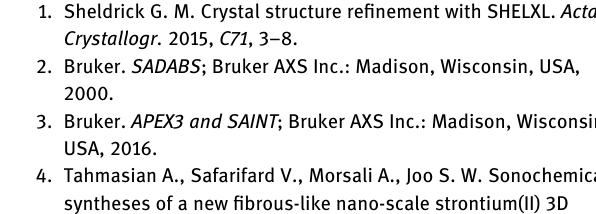
(1 H -imidazole-4,5-dicarboxylate anion (H Phbidc 2 − ), two 4 halfs of coordination water molecules and two uncoordi- nated water molecules. Each Ni1 ion is six-coordinated and located in a distorted octahedral NiN O coordination 2 4 environment formed by two N atoms (N1 and N1#1) and two O atoms (O1 and O1#1) from one H Phbidc 2 − anion and by 4 two water molecules (O5 and O6). The Ni – N bond lengths is 2.0133(18) Å and the Ni – O bond lengths are 2.046(3), 2.099(3), 2.1028(16) and 2.1029(16) Å, respectively; these values are within the normal ranges and close to those reported in other Ni(II) complexes [15 – 17]. The bond angles of O6 – Ni1 – O5, N1 – Ni1 – O1#1 and N1#1 – Ni1 – O1 are 171.94(12) ° , 173.30(7) ° and 173.30(7) ° , respectively. The other bond angles around the Ni1 ion are more or less are O – H ⋯ O intramolecular hydrogen bonds between carboxyl and carboxylate groups, N – H ⋯ O intermolecular hydrogen bonds between imidazole units and solvent water molecules and O – H ⋯ O intermolecular hydrogen bonds involving coordination water molecules, solvent water molecules and carboxylate groups. Furthermore, there are π – π stacking interactions between C6/C7/C8/ distance of 3.6002(1) Å, which are in the range for common are linked by the above hydrogen bonds and π – π in- teractions, resulting in a three-dimensional supramolecu- lar architecture in the solid state.